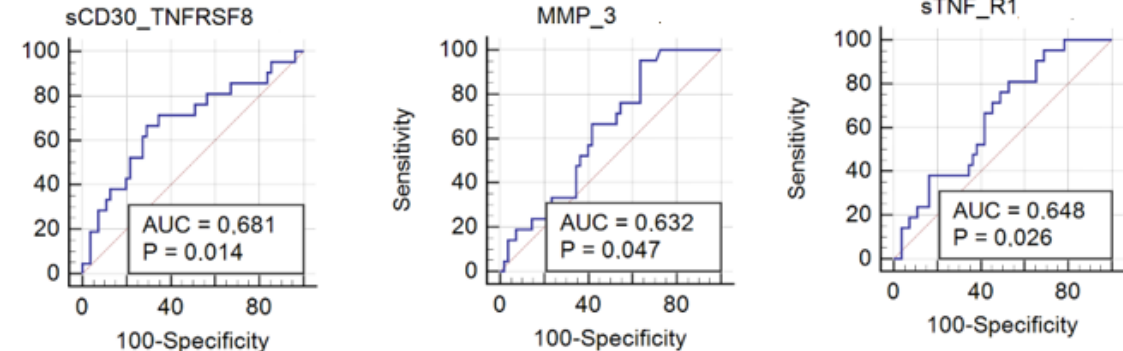
Figure 2. Univariate receiver operating characteristic (ROC) curve representing correlation between serum concentrations of MMP ‐ 3, sCD30/TNFRSF8, and sTNF ‐ R1 in allergy patients and control group. (sTNF ‐ R1 sensitivity: 81%, specificity 47.3%; sCD30/TNFRSF8 sensitivity: 66.67%, specificity 70.91%; MMP ‐ 3 sensitivity: 95.24%, specificity 36.36%).